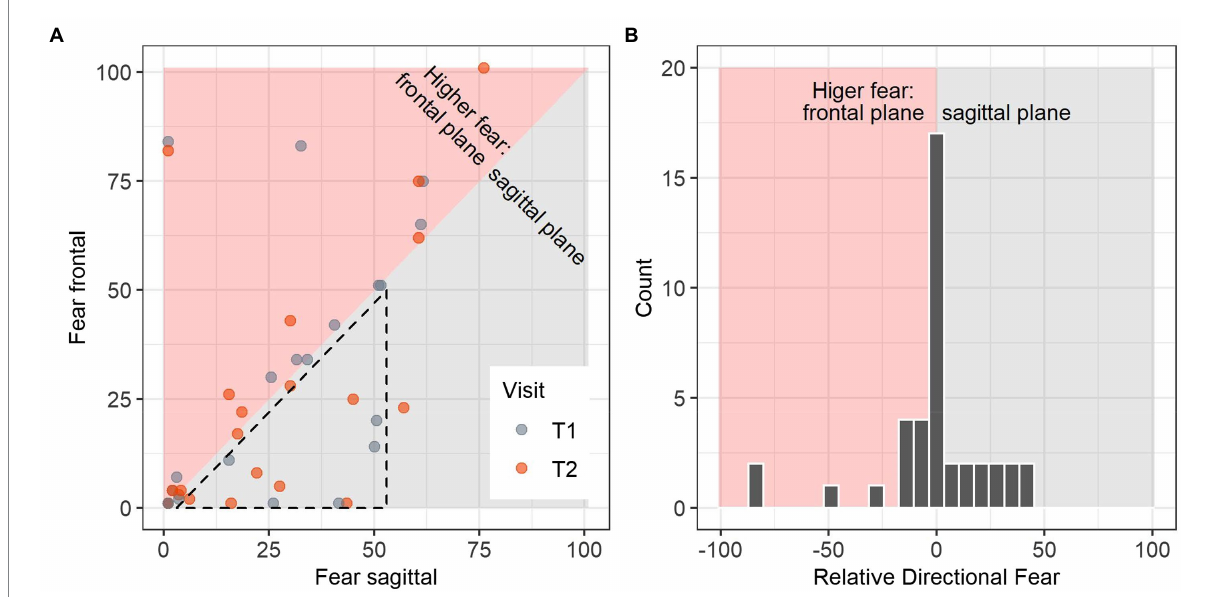
FIGURE 2 Relative directional fear is calculated by subtracting fear ratings for the frontal plane from fear ratings of the sagittal plane. Background in red shade indicates higher fear values for the frontal plane, gray shade background shows area of higher fear in the sagittal plane. (A) Ratings of fear in the sagittal and the frontal plane. The dashed triangle highlights that participants who rated fear in the sagittal plane higher than fear in the frontal plane showed low to medium values on both planes. (B) Distribution of relative directional fear. Negative values for relative directional fear show higher fear of frontal plane movements and positive values show higher fear of sagittal plane movements.